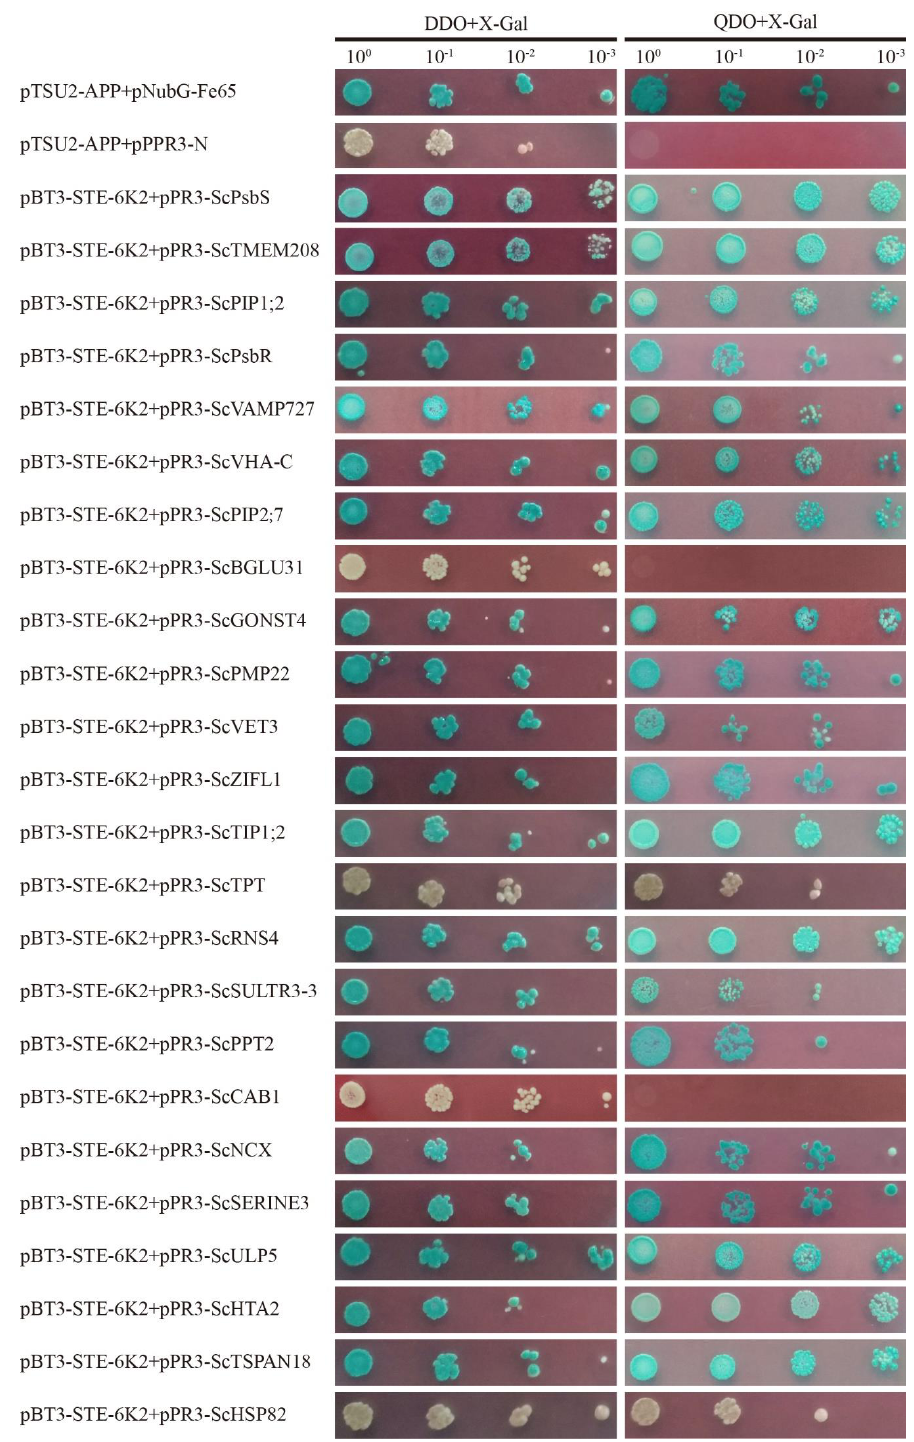
Figure 3. Verification of protein interaction by yeast two hybrid assays. The coding sequences of 24 proteins were individually infused into the prey vector pPR3 and co-transformed with the bait vector pBT3-STE-6K2 into the yeast NMY51 cells in a 10 × dilution series of 10- µ L aliquots, which were then plated on non-selective medium (DDO + X-Gal) or a high-stringency selective medium (QDO + X-Gal). Yeast cells co-transformed with pTSU2-APP and pNubG-Fe65 were used as positive controls, pTSU2-APP and pPR3-N were used as negative